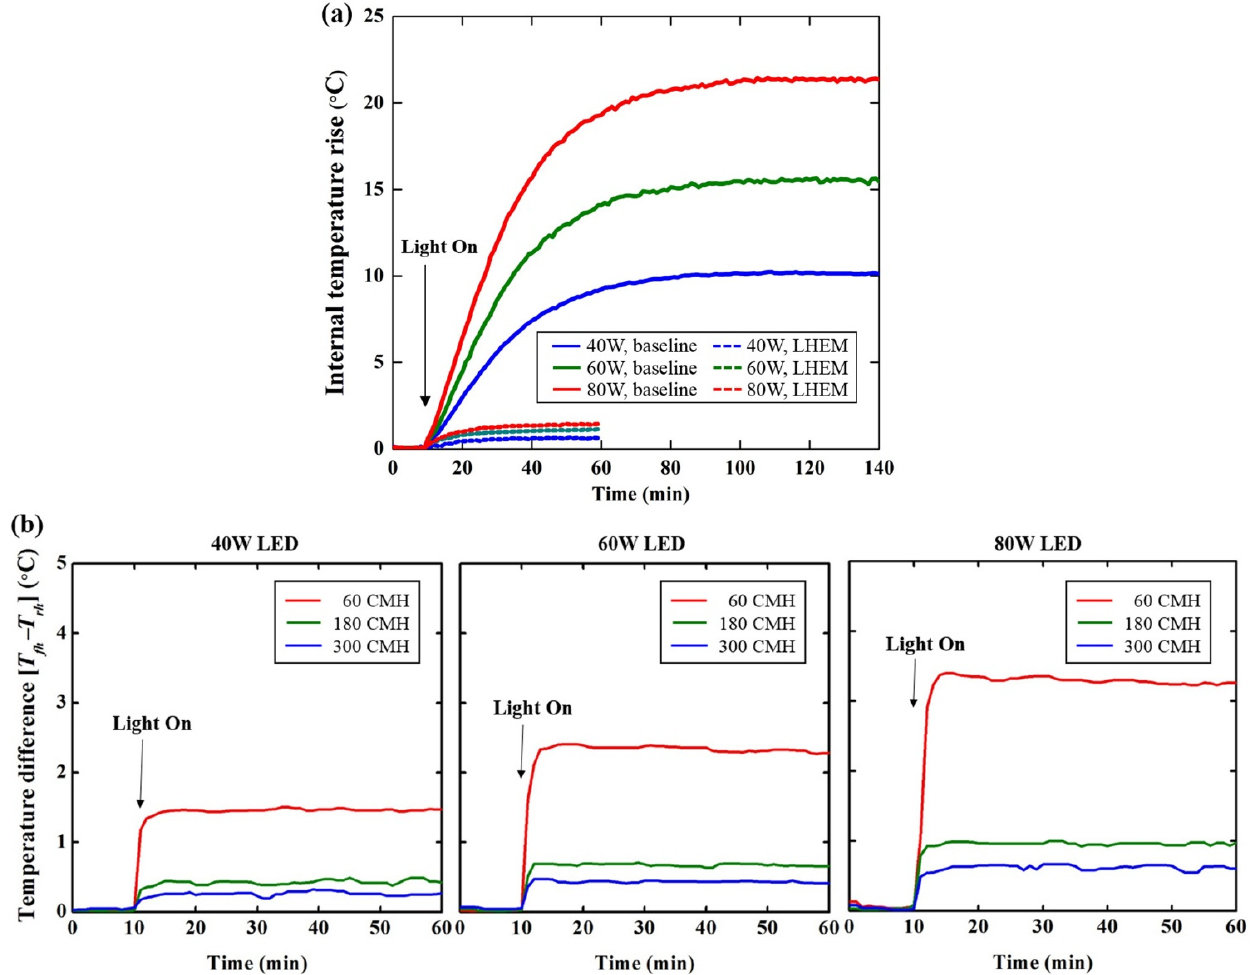
Figure 5. ( a ) Average internal temperature rise in the baseline and LHEM tests and ( b ) temperature difference between the front and rear sides of the heat sink with the